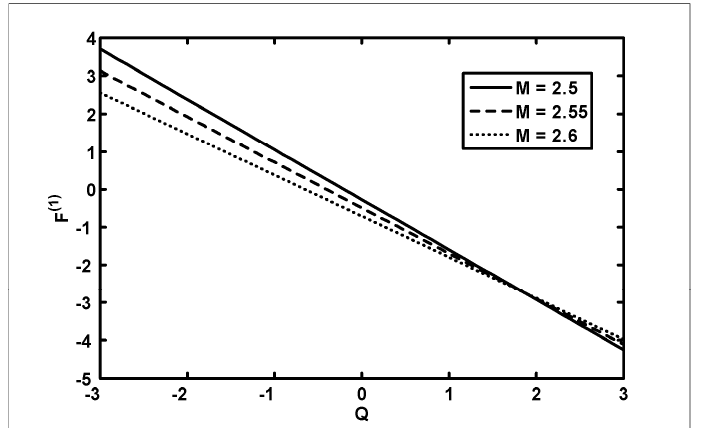
)0( F outer tube) with Q for different values of M at